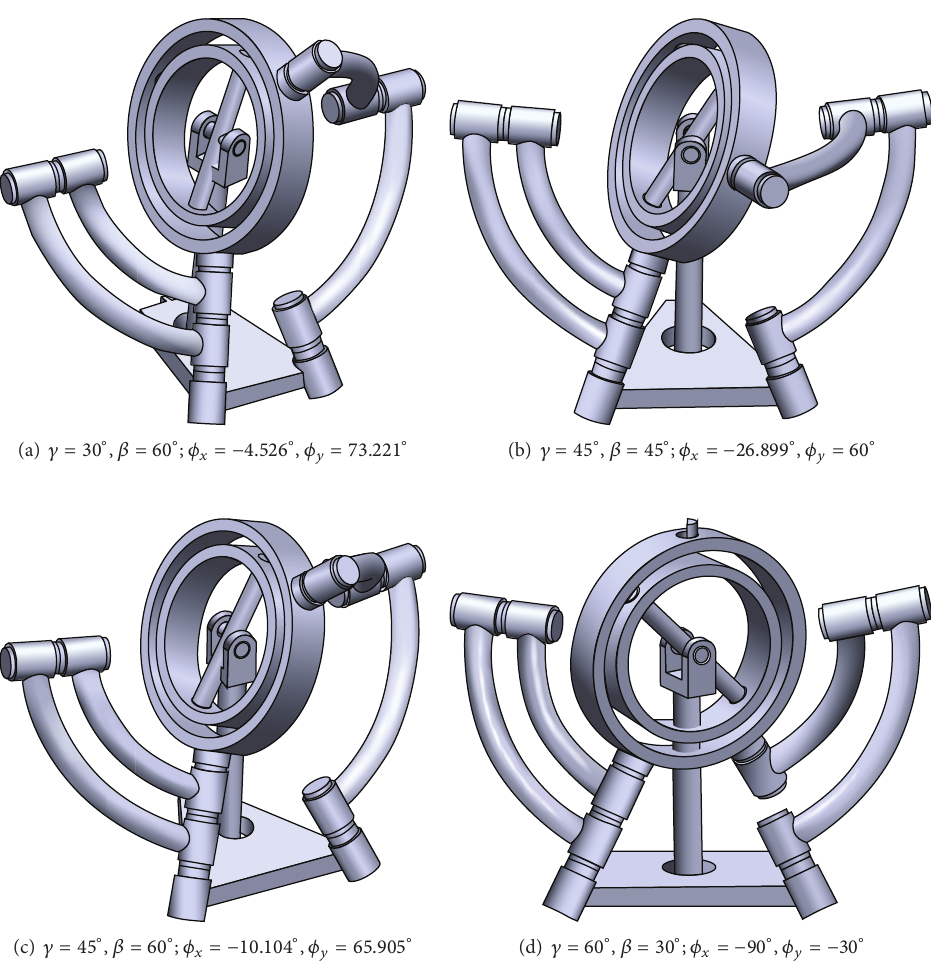
Figure 5: Examples of Type I singularity of the asymmetrical